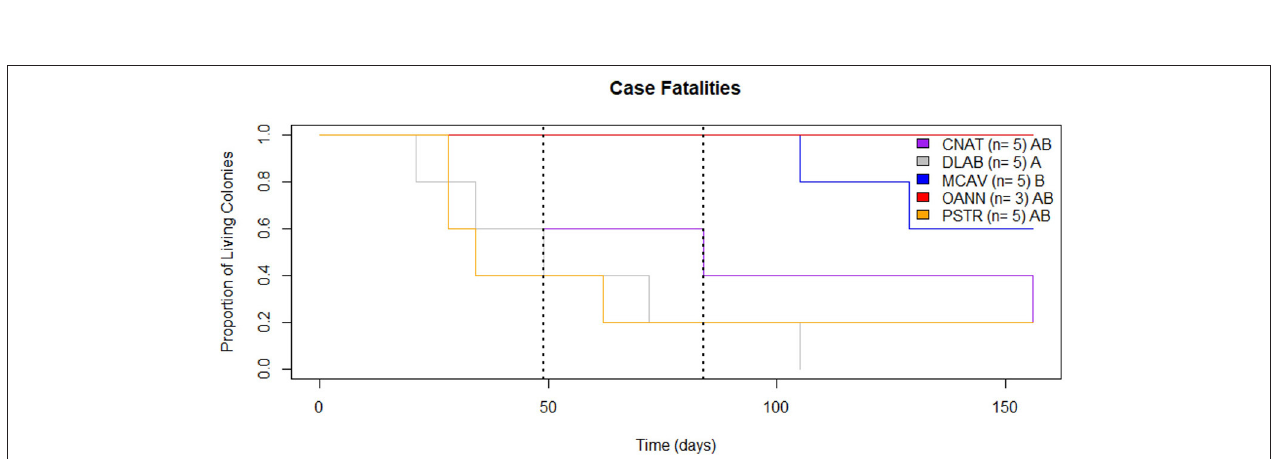
FIGURE 8 | Case Fatalities. Proportion of SCTLD affected colonies alive throughout the monitoring period (August 13th, 2019 to January 16th, 2020). The dashed lines mark the beginning of the bleaching event (Left) and beginning of recovery (Right) . Species with distinct letters (see legend) are statistically different.